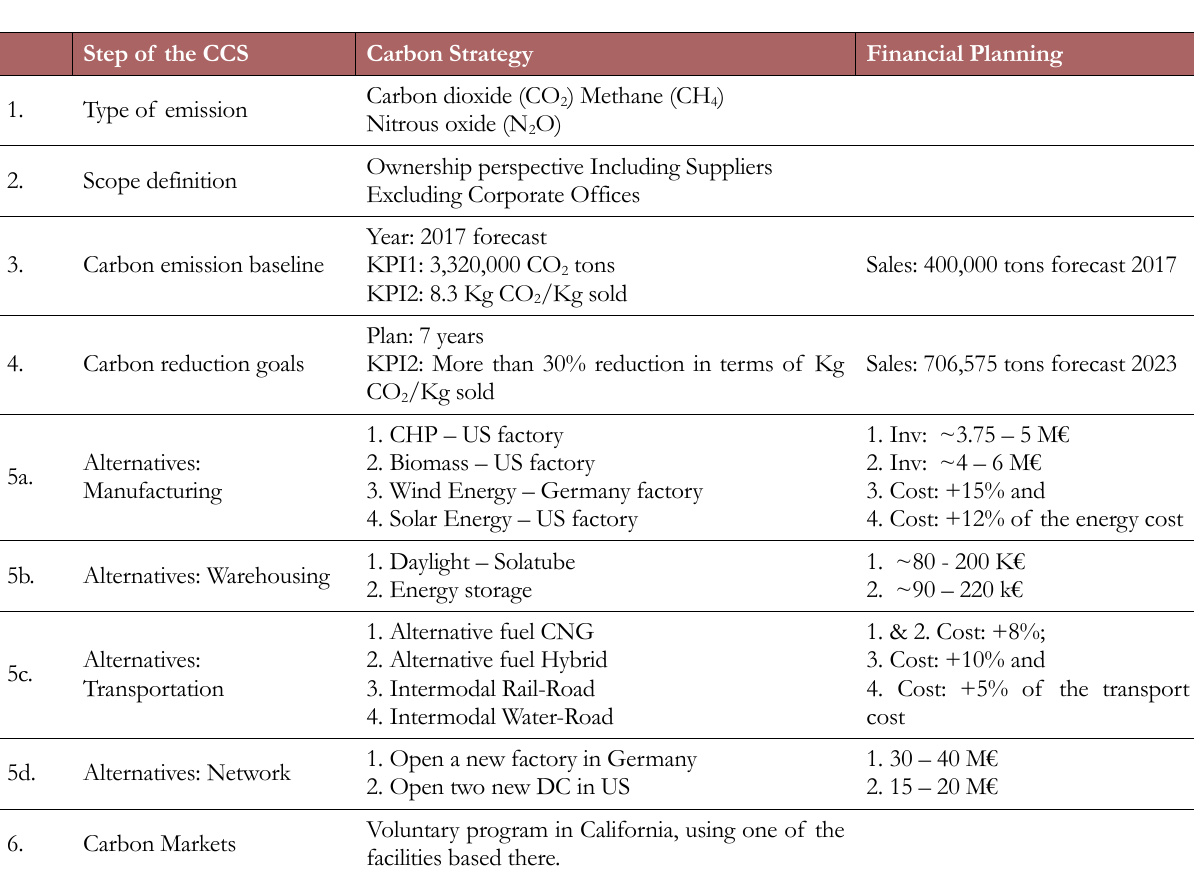
Table 1. Green Supply Chain